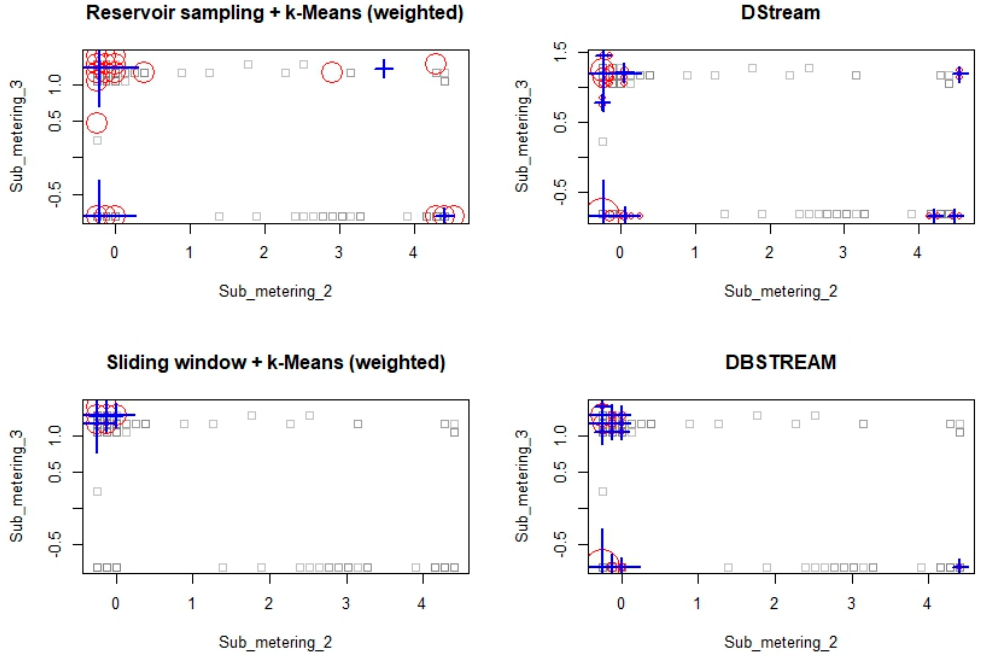
Figure 9. Macro-cluster placement for different data stream clustering algorithms (using real data stream).